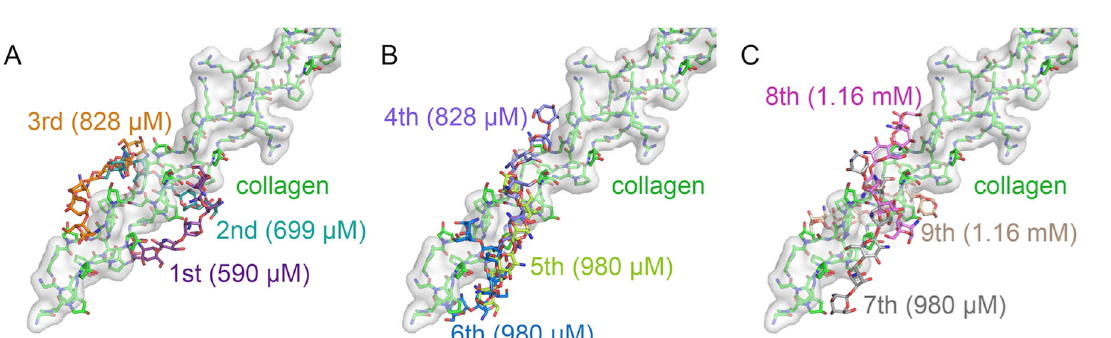
(KD), as 1st to 3rd ( A ), 4th to 6th ( B ), and 7th to 9th ( C ). The synthetic collagen peptide is colored green and shown as a transparency surface